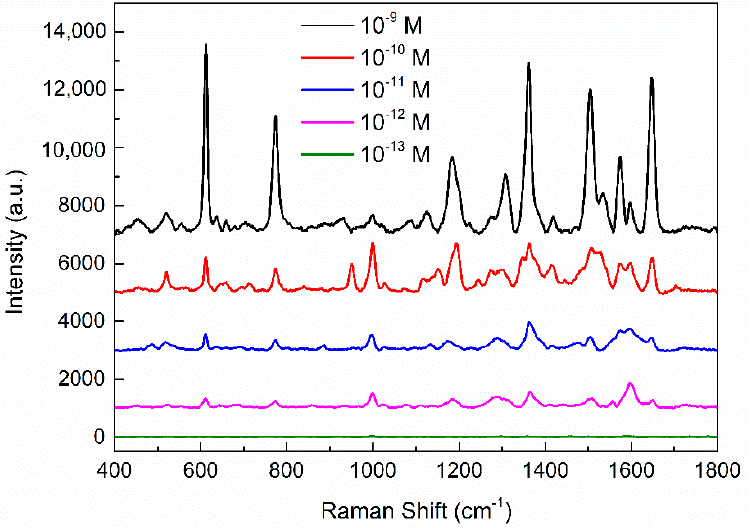
Figure 8. The SERS spectra of various concentrations of R6G solution (ranging from 10 − 9 M to 10 − 13 M) gathered on Ag/IPS.